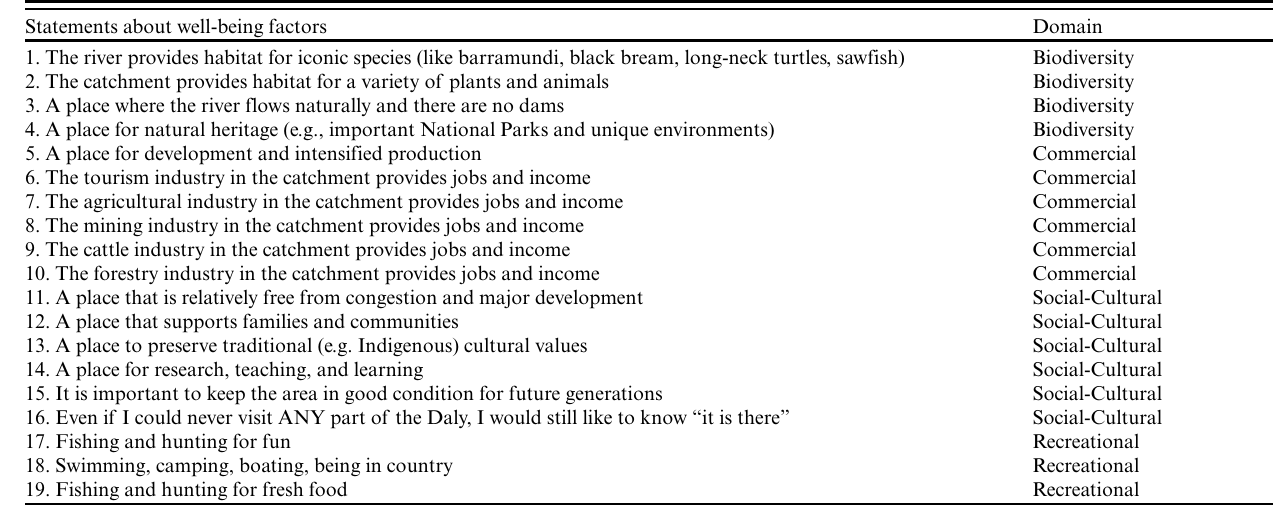
Table 2 . Final list of well-being factors and associated broad domains used in the